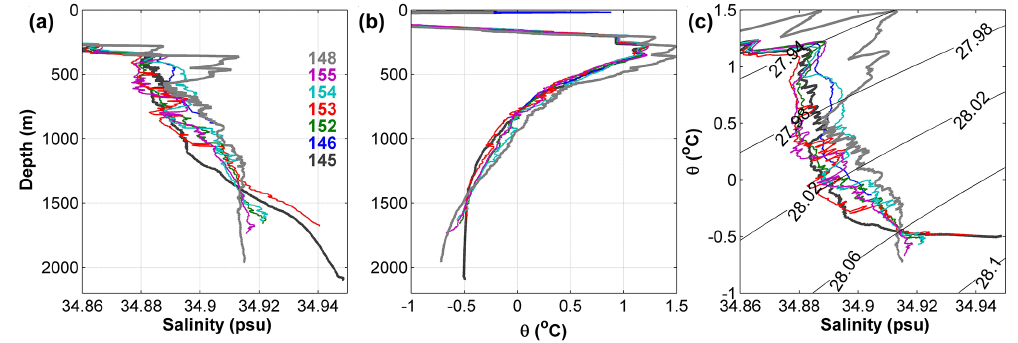
Figure 7. Salinity and potential temperature ( θ ) profiles at the northern passage. The bold curves show reference stations in the Makarov Basin (stn. 145) and Amundsen Basin (stn. 148). For positions of the stations, please refer to Figs. 1 and 2.